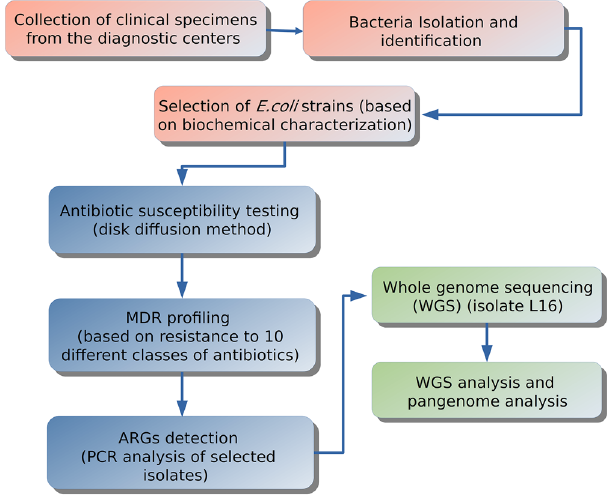
Figure 1. Schematic illustration of workflow of the entire procedure and